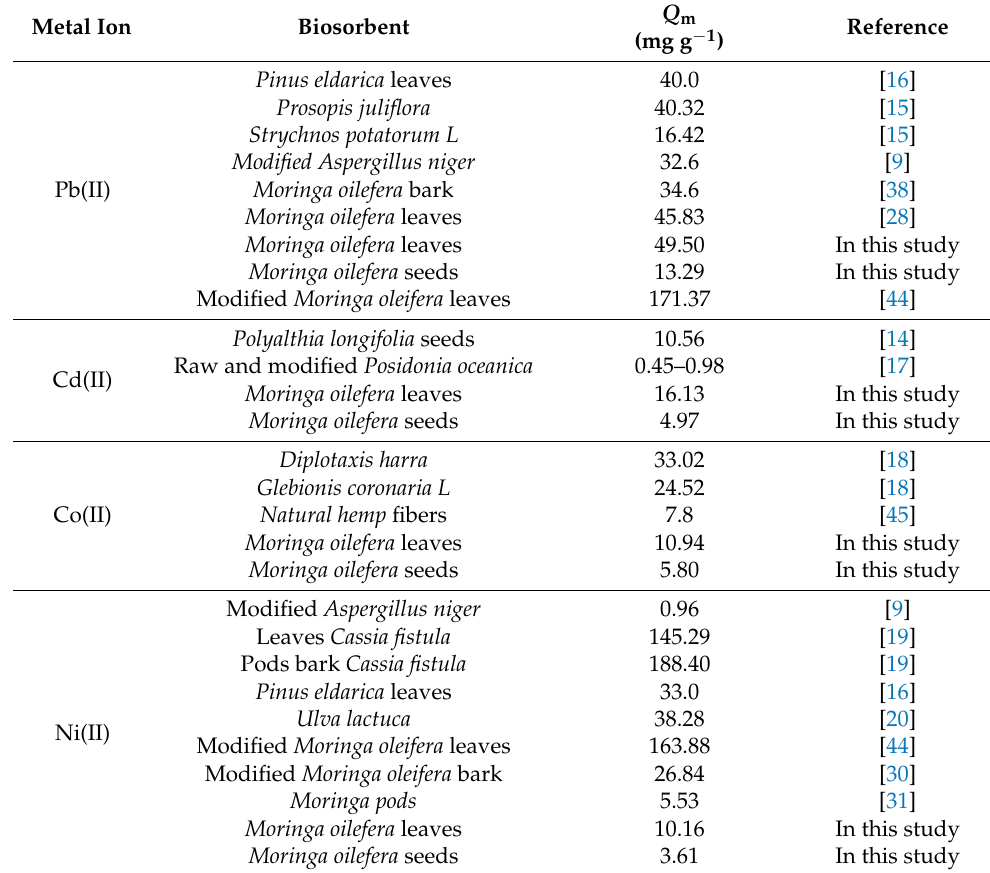
Table 3. Comparison of L-MO and S-MO with other biosorbents to remove Pb(II), Cd(II), Co(II), and Ni(II) from aqueous